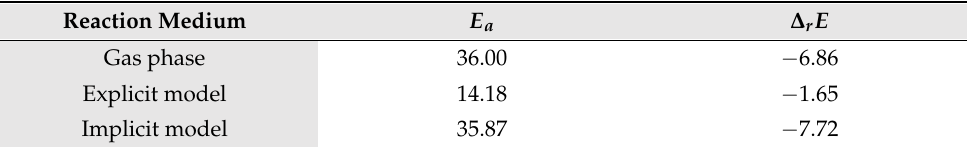
Table 1. Computed activation energy ( E a ) and free energy of reaction values ( ∆ r E ) (in kcal · mol − 1 ) of the studied tautomeric equilibrium as a function of solvation